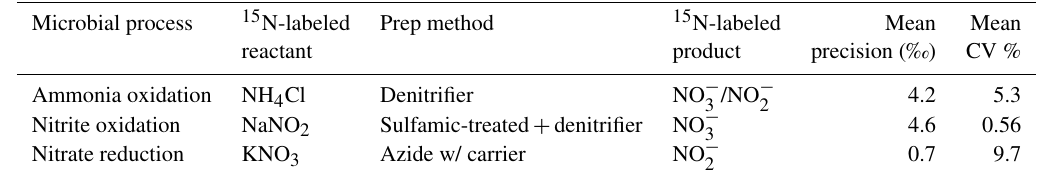
Table 2. Nitrite cycling reactant and product pools as analyzed by isotope rate mass